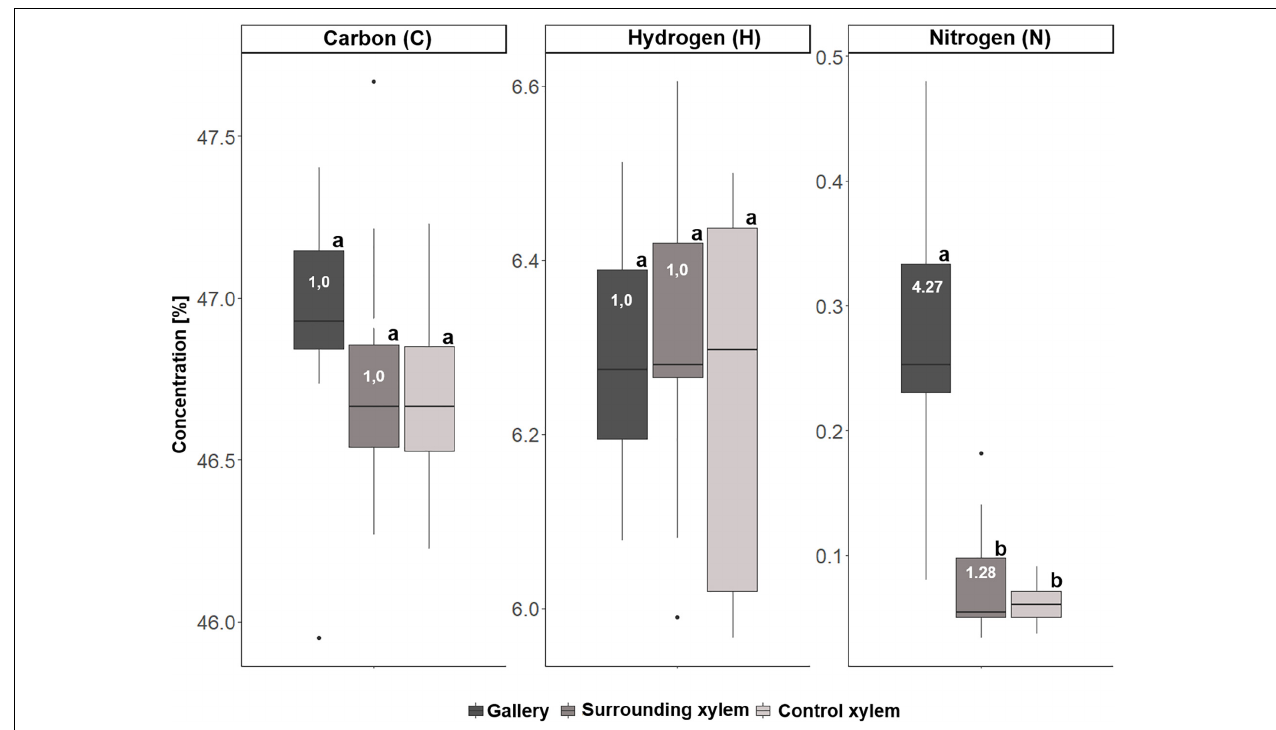
FIGURE 7 | Concentrations of carbon (C), hydrogen (H), and nitrogen (N) for the three types of samples taken from Xyleborinus saxesenii ( N = 9–10 per group): (i) gallery, (ii) xylem next to gallery, and (iii) control xylem. Different letters next to boxplots (a, b) indicate significant differences between the respective group per individual element. Enrichment ratios (white numbers) for treatment i and ii were added to boxplots for each